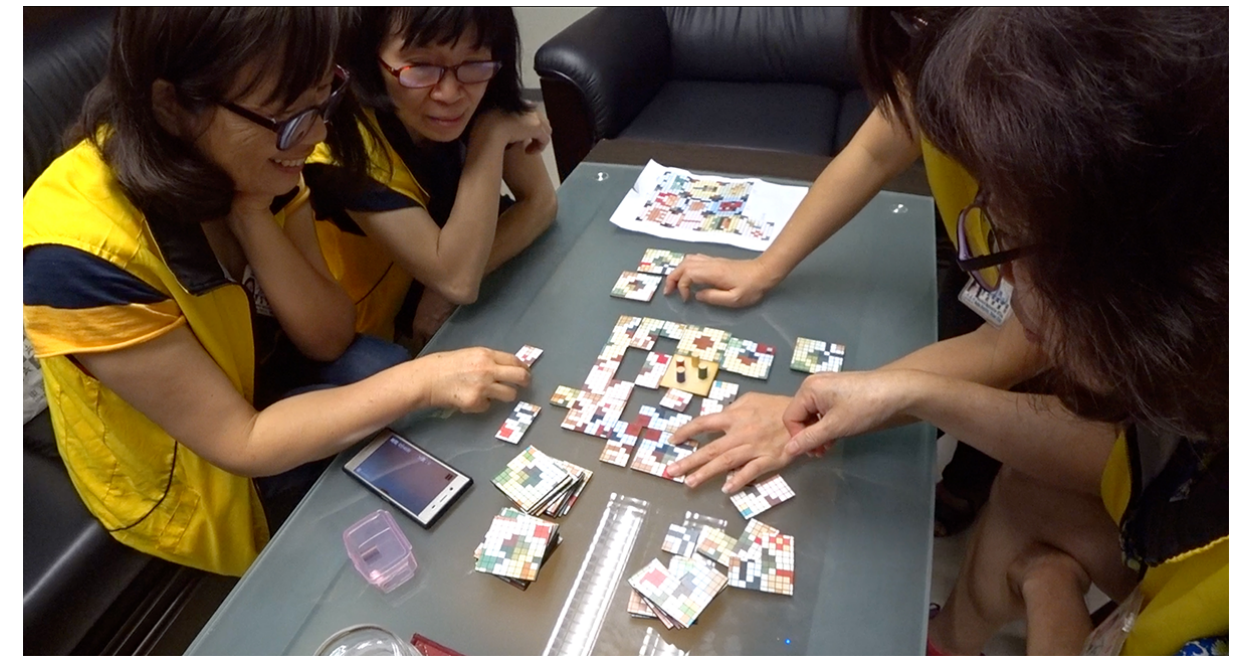
Figure 5. Four participants played the game in one of the game-testing workshops.